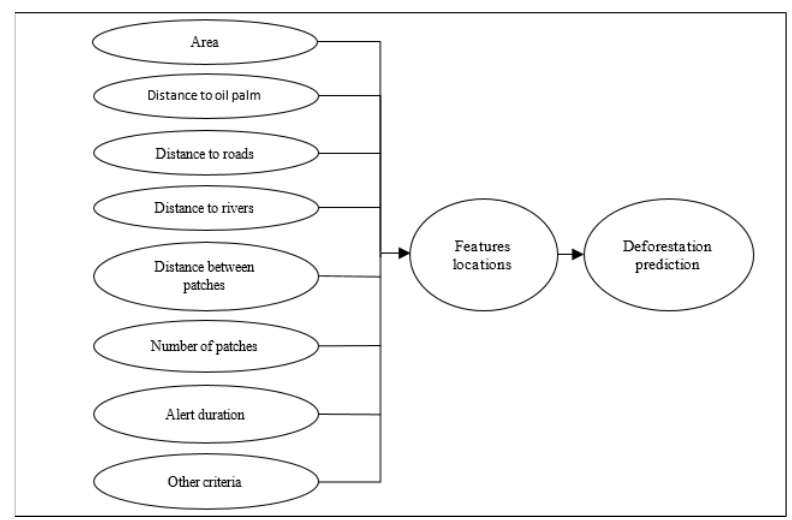
Figure 2. Defined criteria for predicting deforestation related to oil palm.